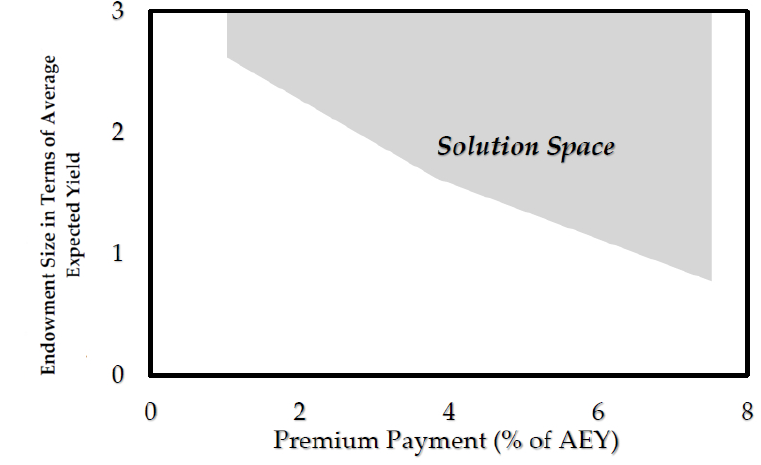
Figure 6. The required initial endowment size for various premium rates, based on 1977–2014 data.